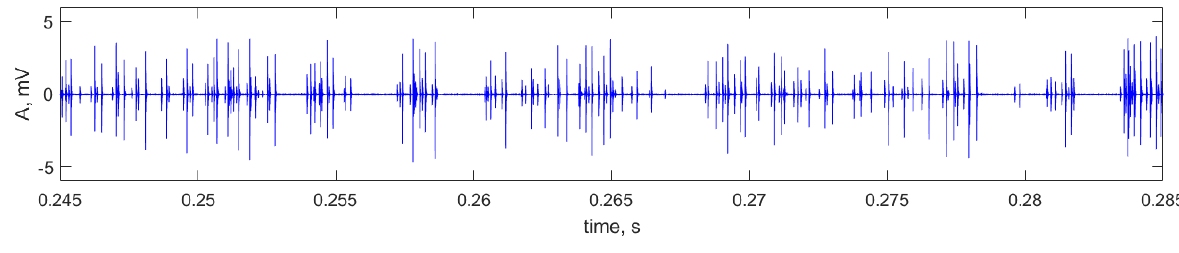
Figure 7. Typical shape of a noise signal.